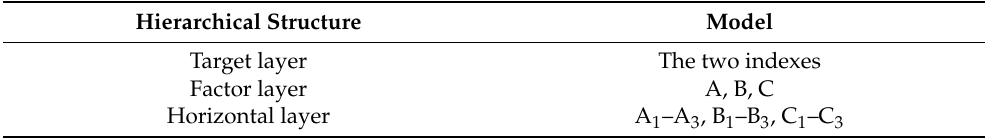
Table 5. Matrix analysis model of multi-objective orthogonal test. Hierarchical